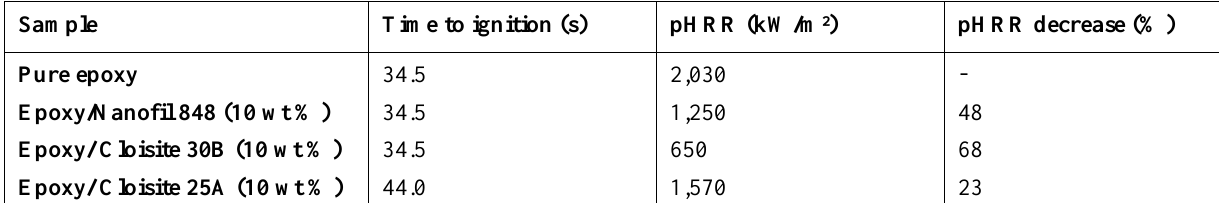
Table 2. Cone-calorimeter data of epoxy-nanocomposites at 50 kW/m²[15].